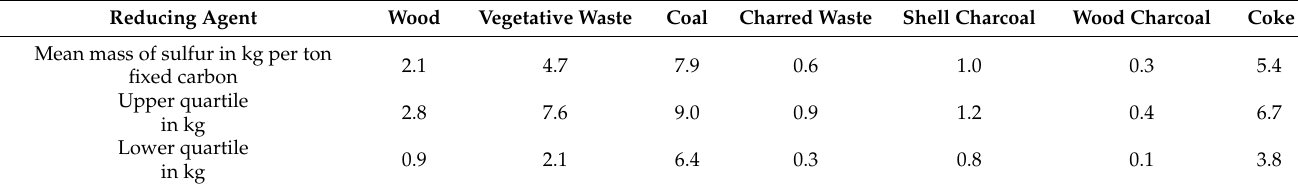
Figure 4. Van Krevelen diagram including different reducing agents used to produce ferroalloys in an industrial-scale or in research facilities. Table 5. Mass of sulfur in relation to a constant fixed carbon amount in reducing